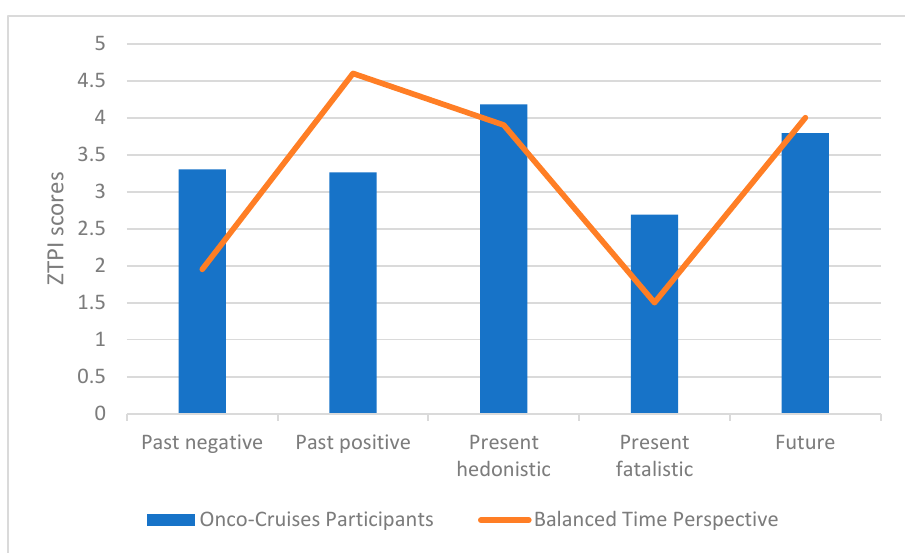
Figure 1. Distribution of NEO-FFI in sten scores.